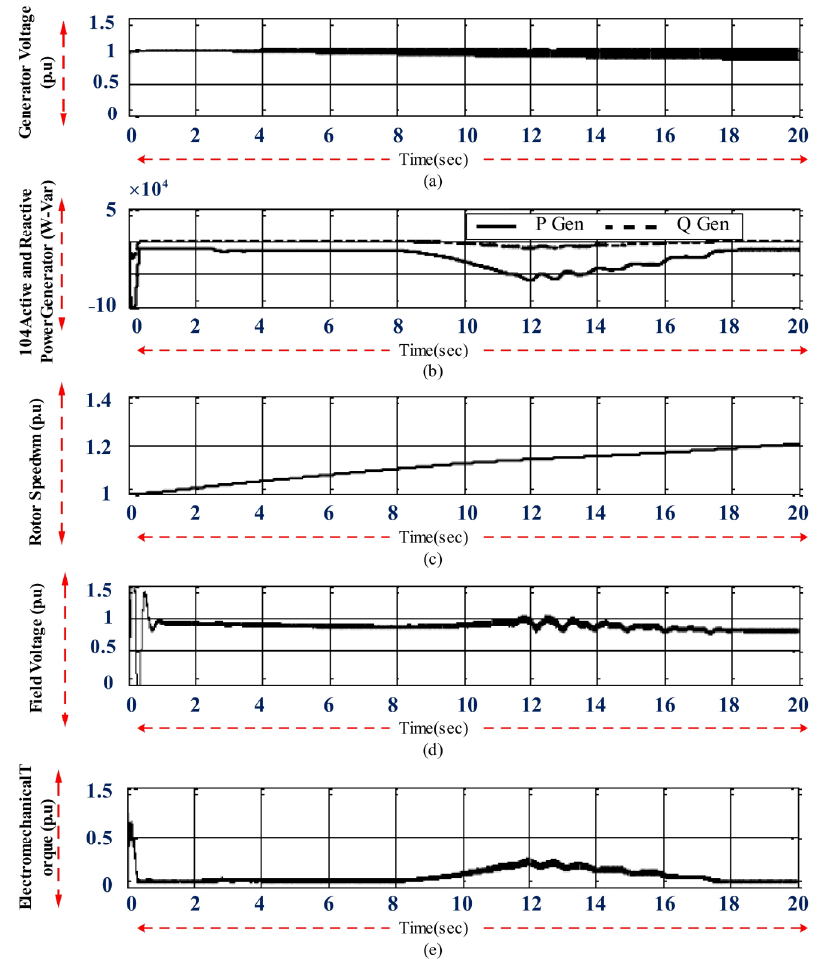
Figure 20. The behavior of the diesel generator in the microgrid. ( a ) Generator bus voltage; ( b ) active and reactive power exchange of the generator with the EV system; ( c ) angular speed of the genera- tor; ( d ) excitation voltage; ( e ) electromechanical torque. ( d ) excitation voltage; ( e ) electromechanical